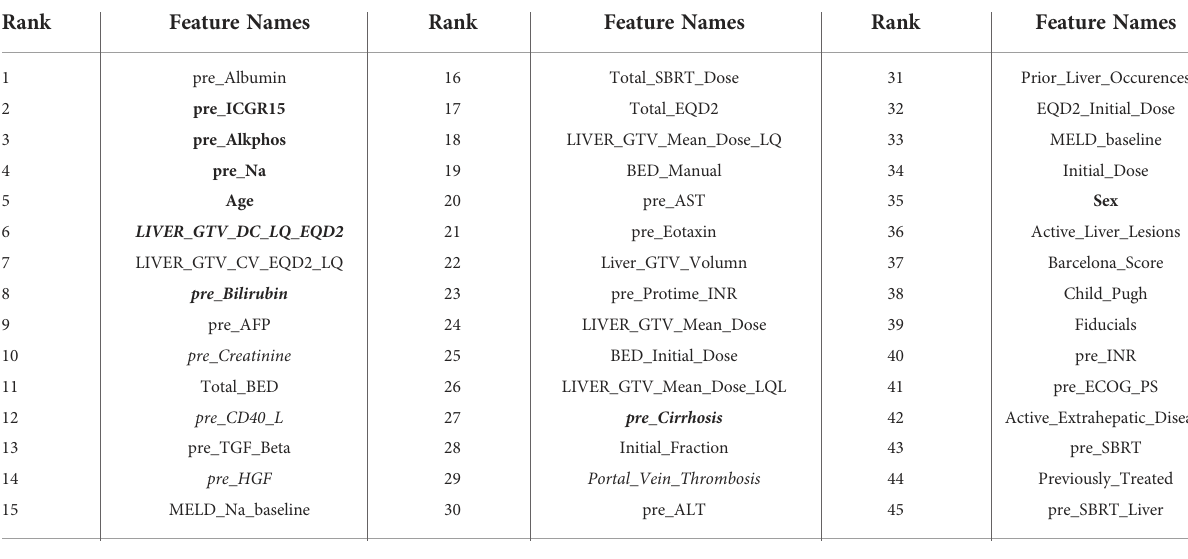
TABLE 3 The rank of features in an integrated feature ranking list for pre-treatment I-ALBI